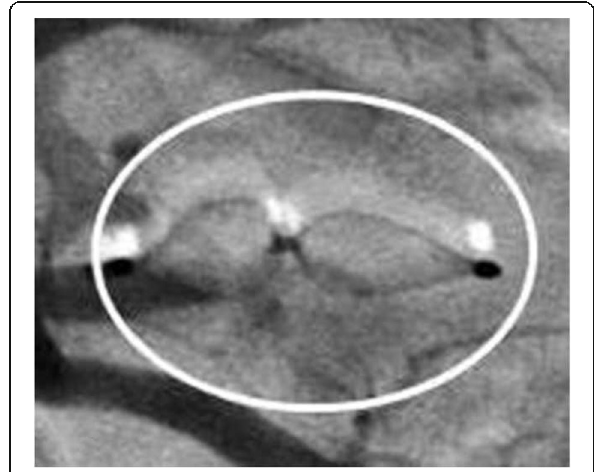
Fig. 7 The structural characteristics of the AVP IV that is composed 2 lobes and a single